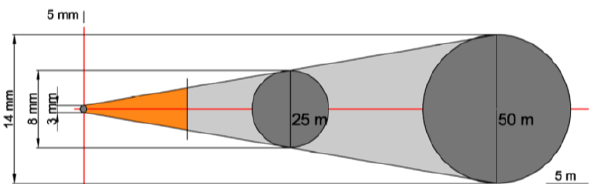
Figure 6. “Mixed pixel” effect Technical specifications for HDS 6000 consider a Gaussian beam, with a divergence linearly increasing: 3 mm at exit and a divergence of 0,22 mrad.